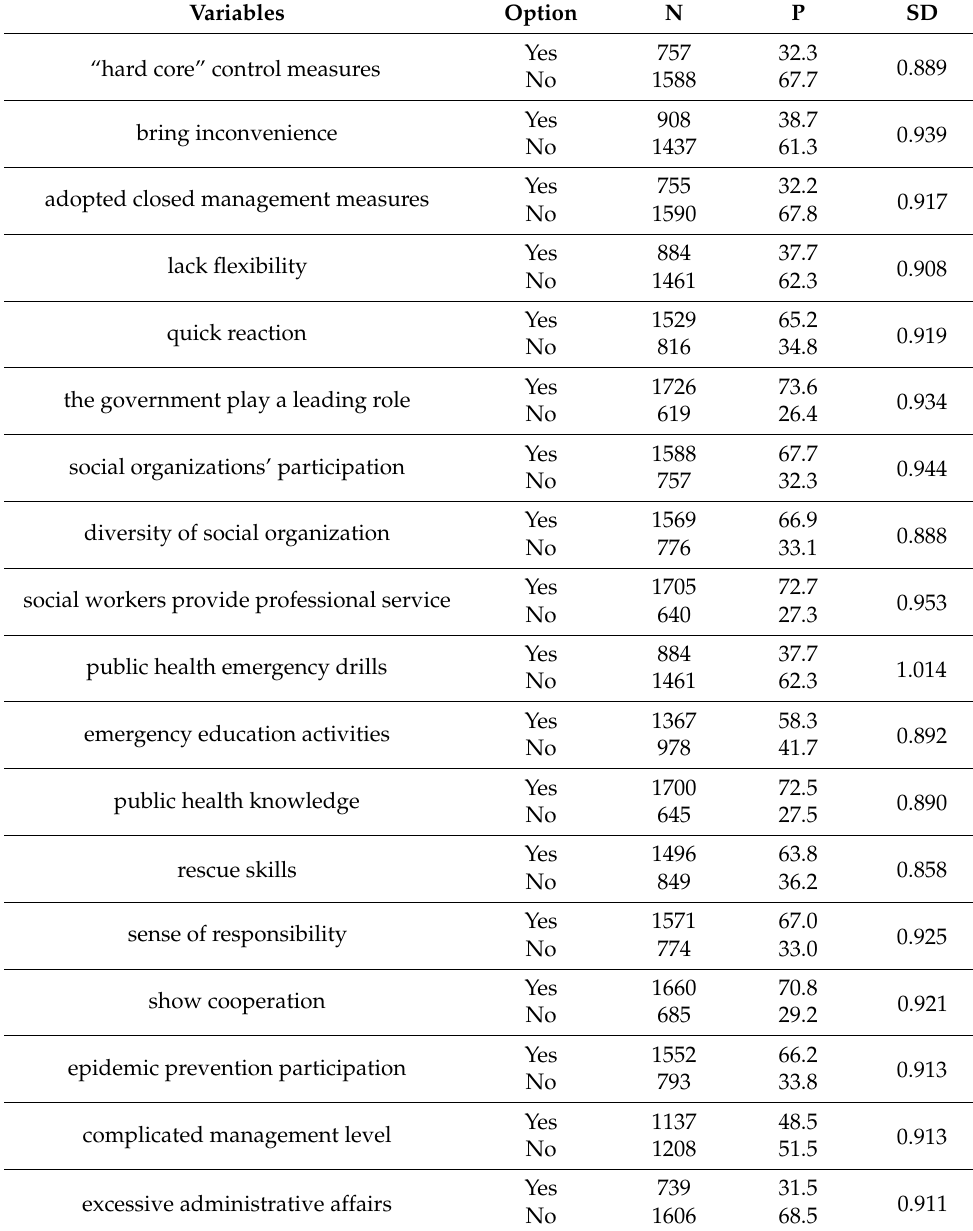
Table 1. Key variables of the state of community public health crisis